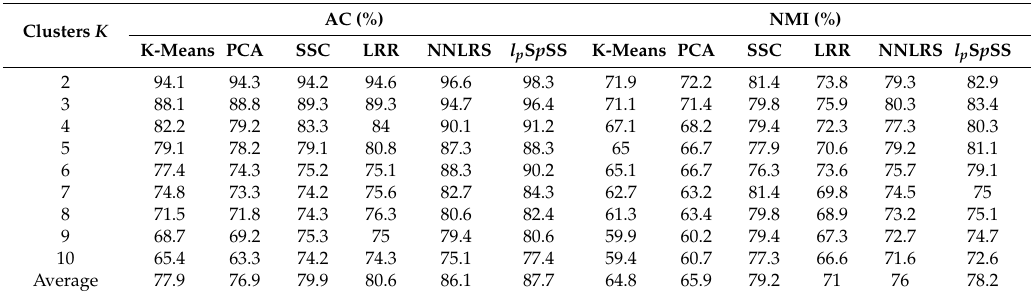
Table 3. Segmentation results of proposed and existing algorithms USPS handwritten digit dataset. Clusters K